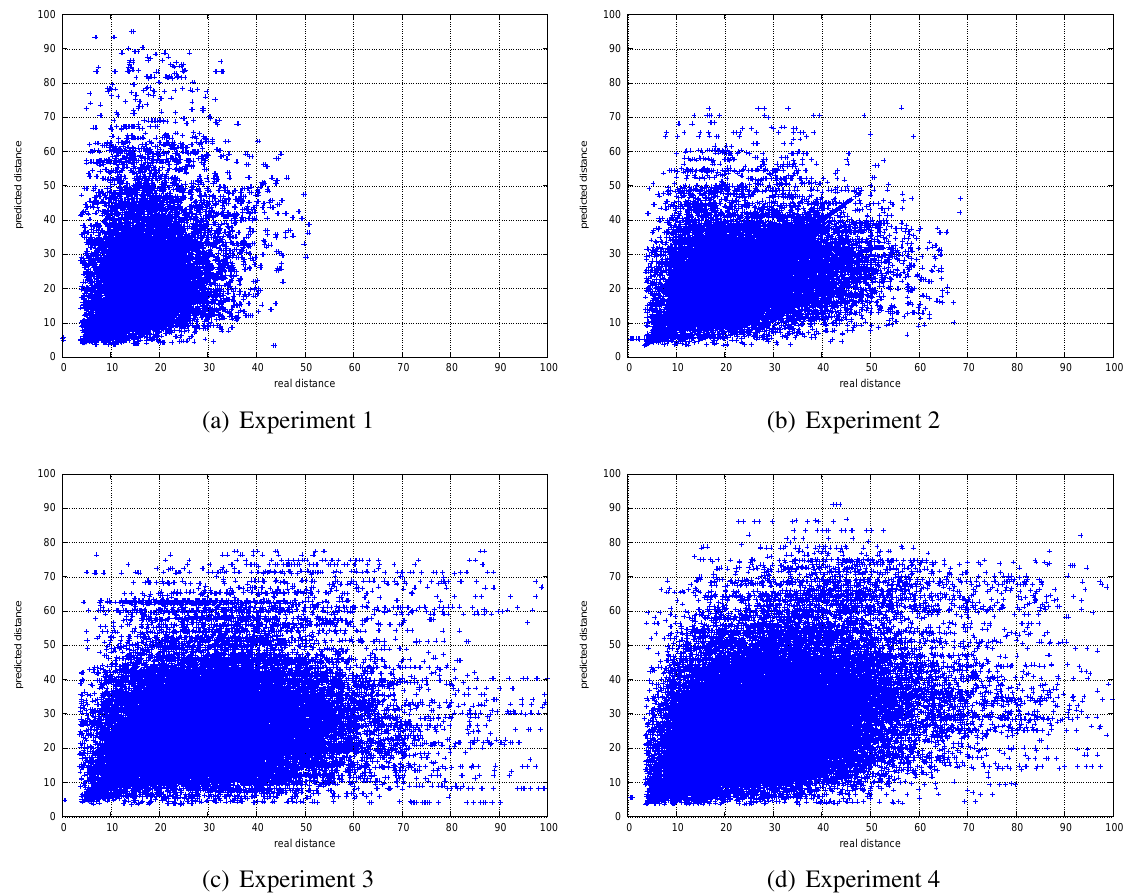
Figure 9: Real and predicted distances in experiments 1, 2, 3 and